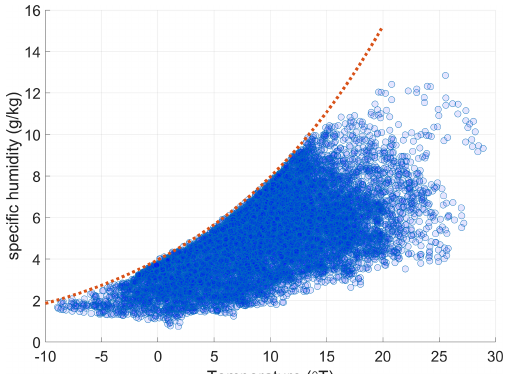
Figure 7. Observed specific humidities plotted against simultane- ous observations of temperature. The red line shows the saturation specific humidity at the lowest hourly average atmospheric pressure of the observations